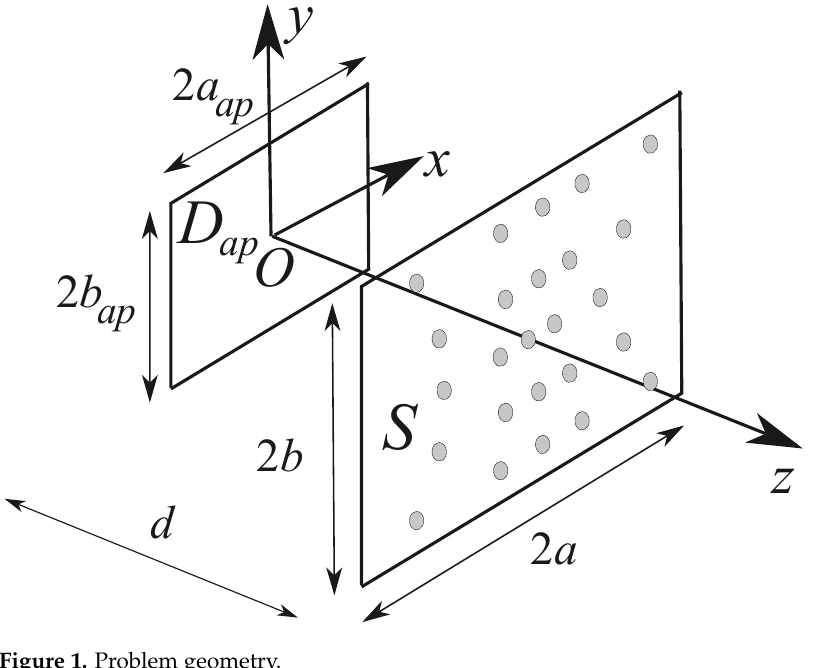
Figure 1. Problem